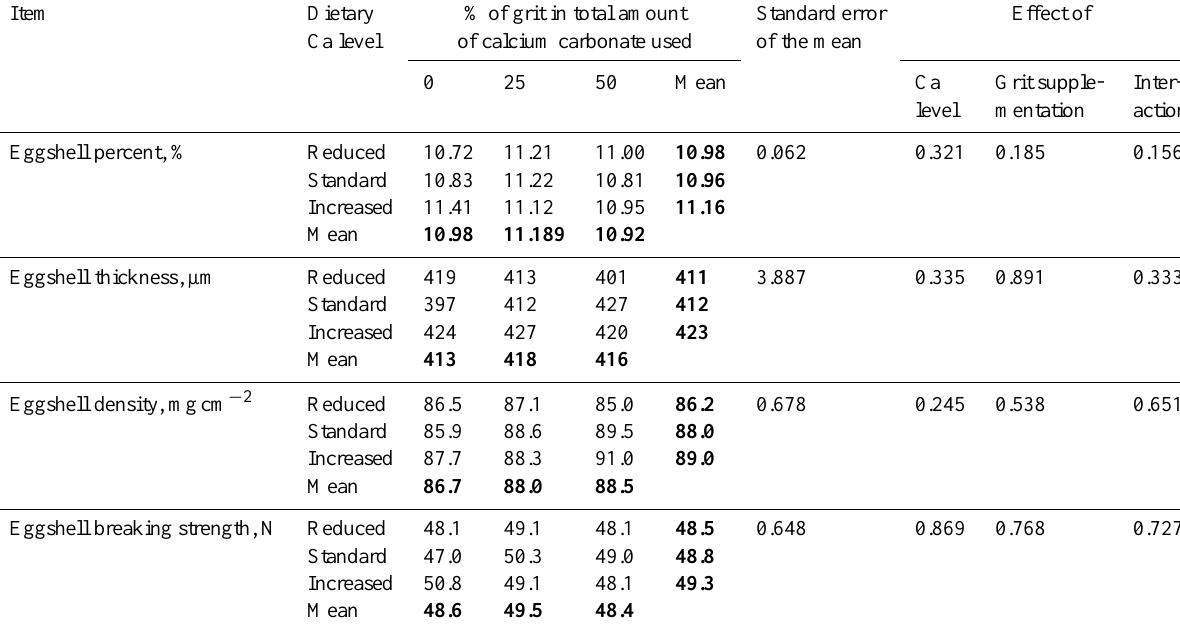
Table 2. Effects of dietary treatments on eggshell quality at 30 weeks of age.